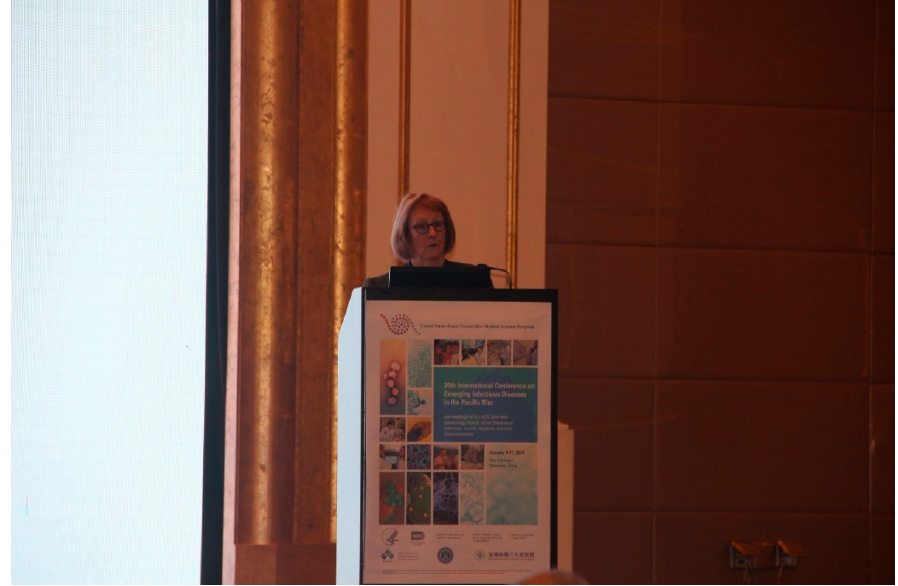
Figure 1. Dr. Mary Estes—La Montagne-Heilman Lectureship (Photo used with permission from Dr. Estes). Vaccines 2019 , 7 , 35